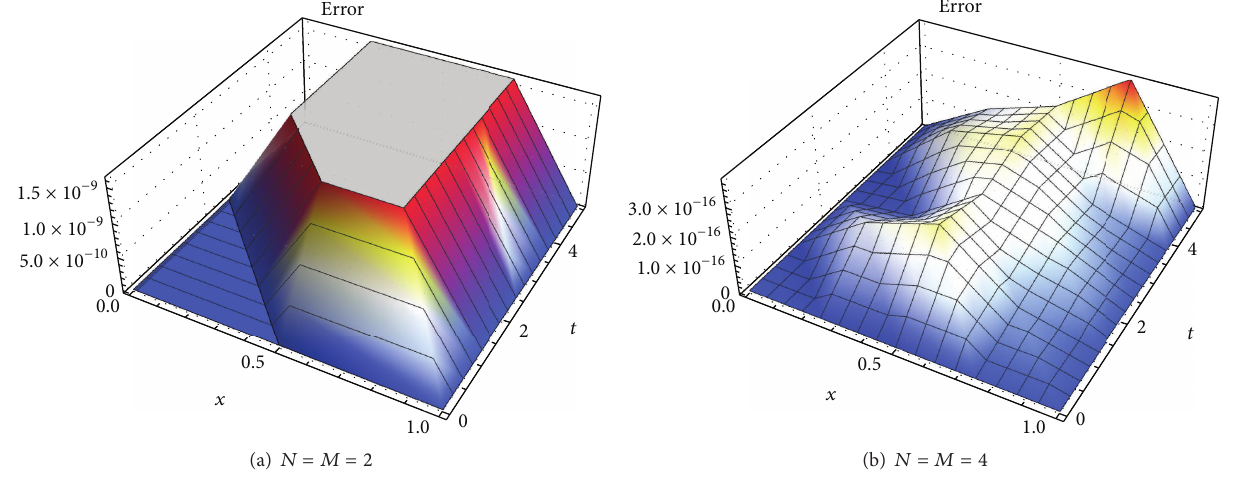
Figure 6: Absolute errors for Example 8.